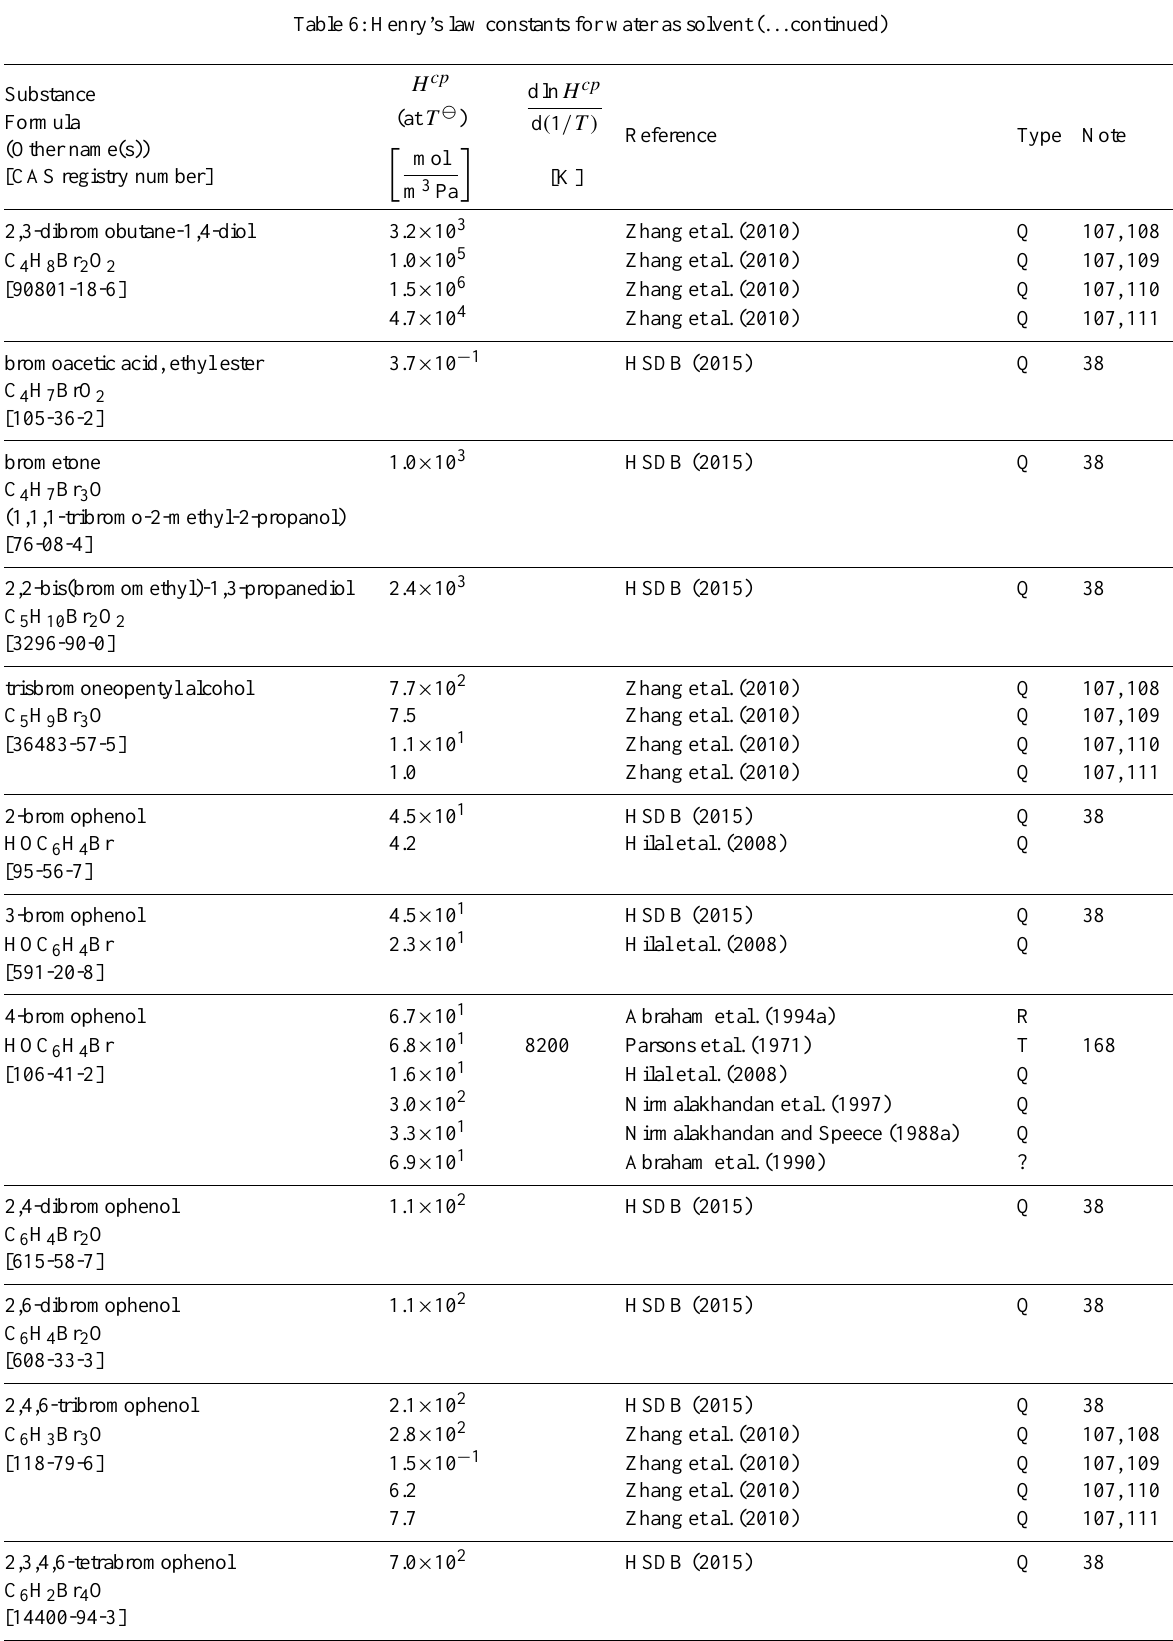
Table 6: Henry’s law constants for water as solvent